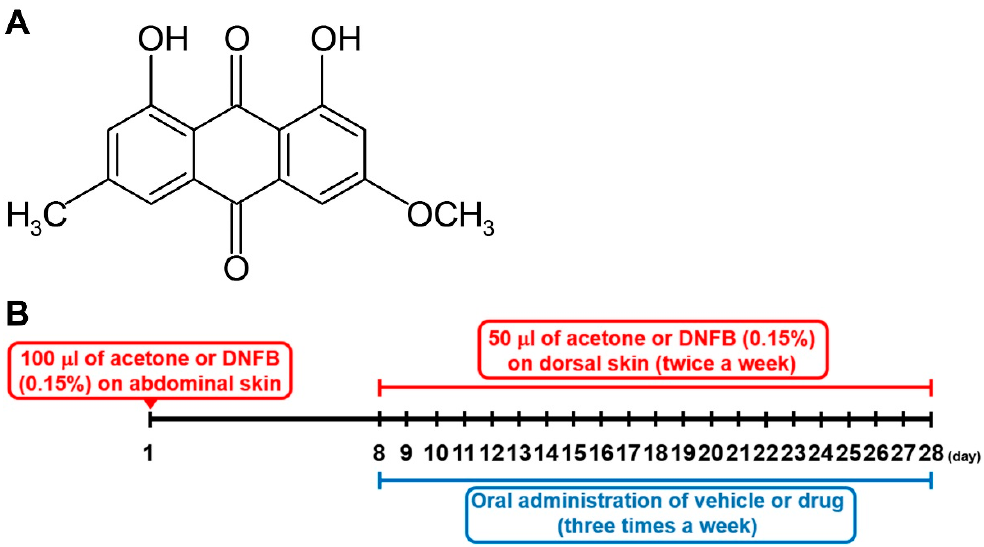
Figure 1. ( A ) Chemical structure of physcion. ( B ) Schematic protocol of a 2,4-dinitrofluorobenzene (DNFB)-induced atopic dermatitis (AD)-like murine model.